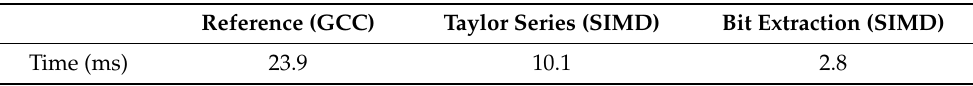
Table 2. Comparison of computation times from the reference, Taylor’s series approximation, and proposed bit extraction